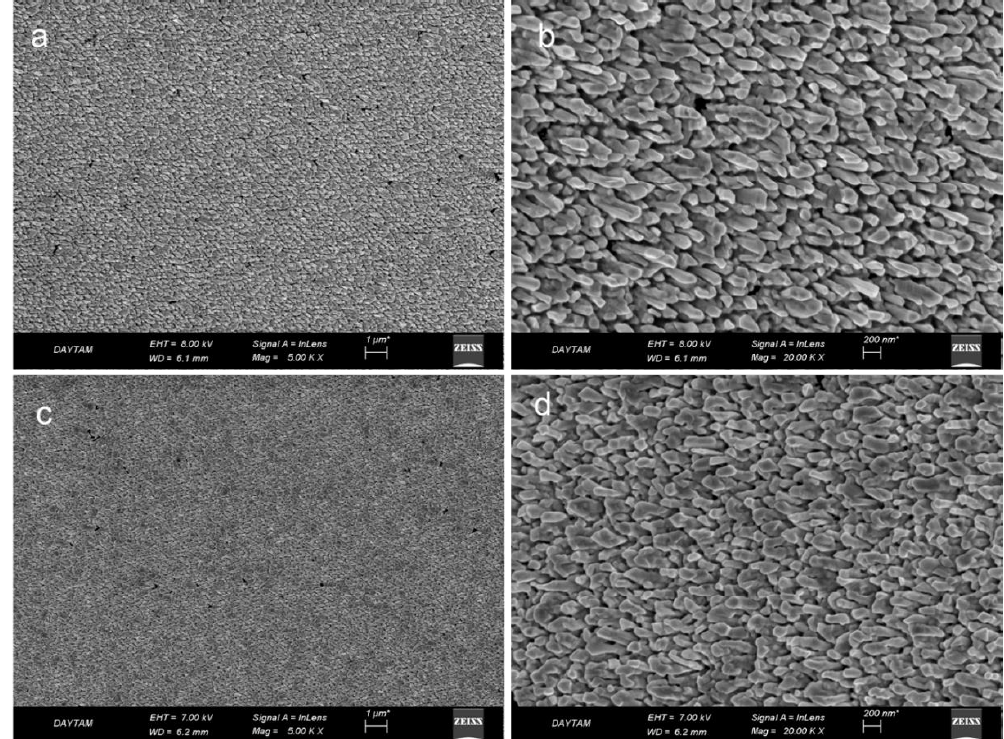
Figure 1. Representative SEM images of GNAs ( a , b ) and GNA@PDOP ( c , d ) at different magnifications. For the case of GNA@PDOP, PDOP deposition time was 30 min.